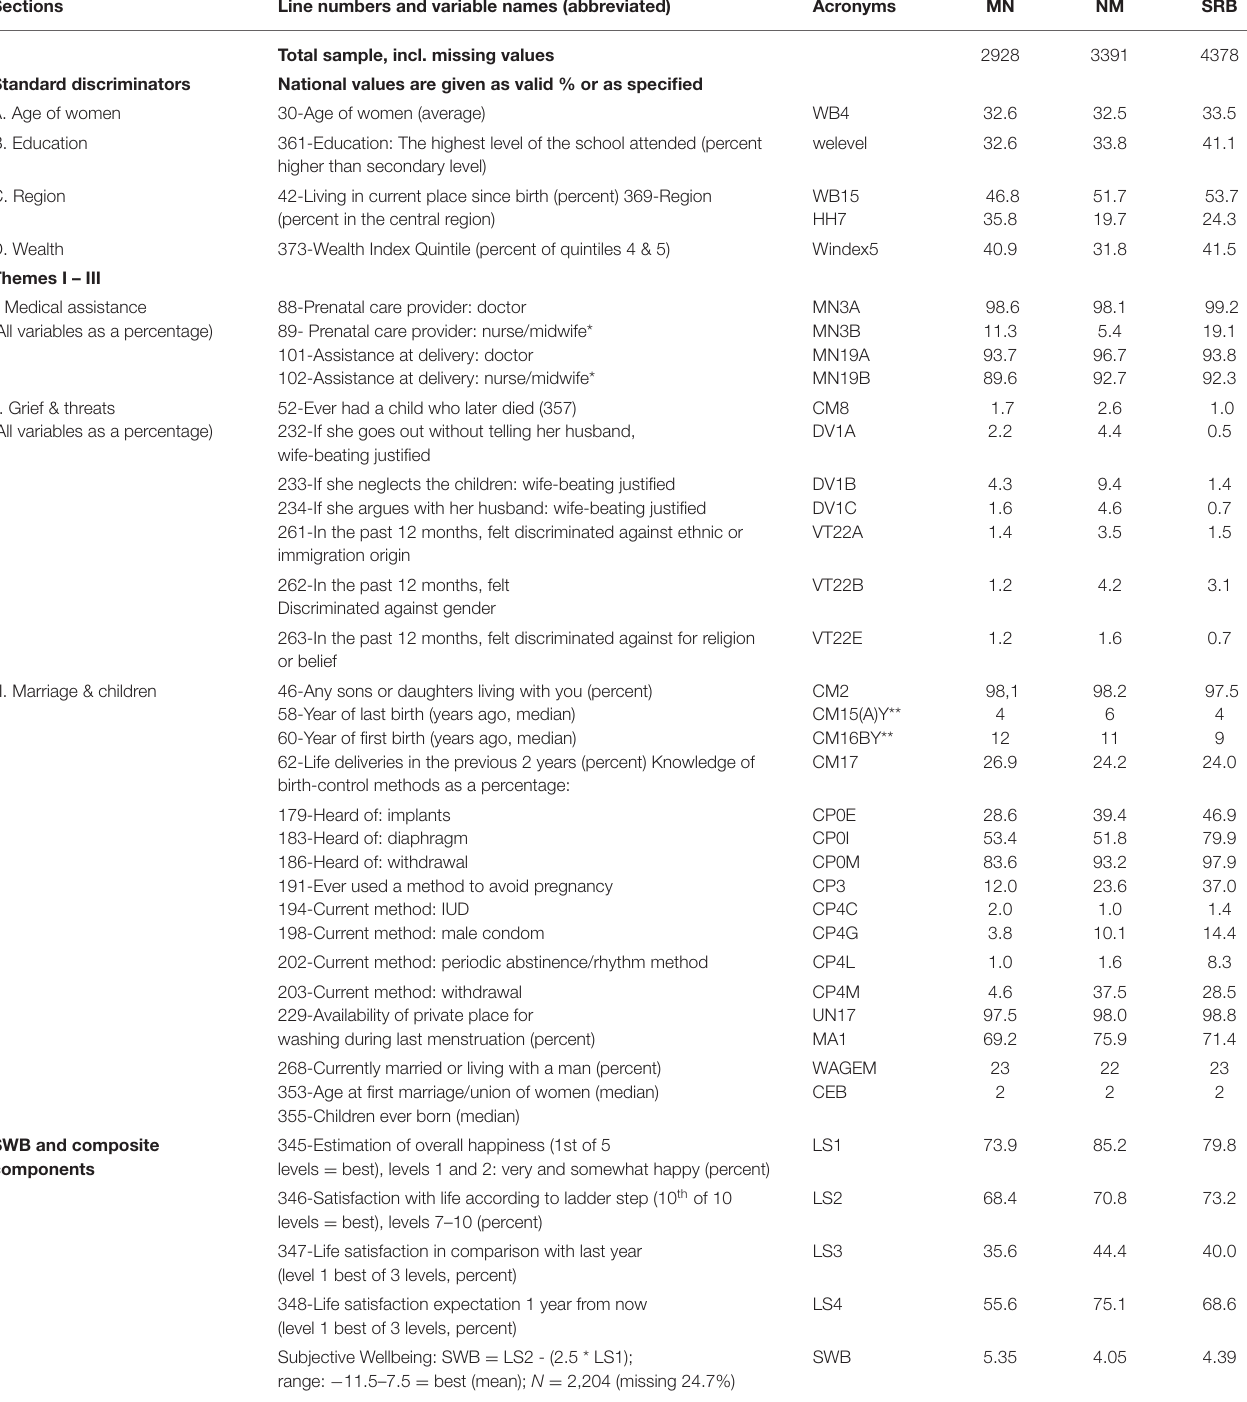
TABLE 2 | Women’s descriptive characteristics and subjective wellbeing